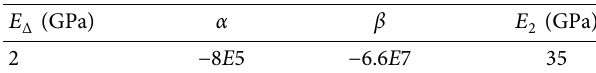
Table 1: Constitutive equation